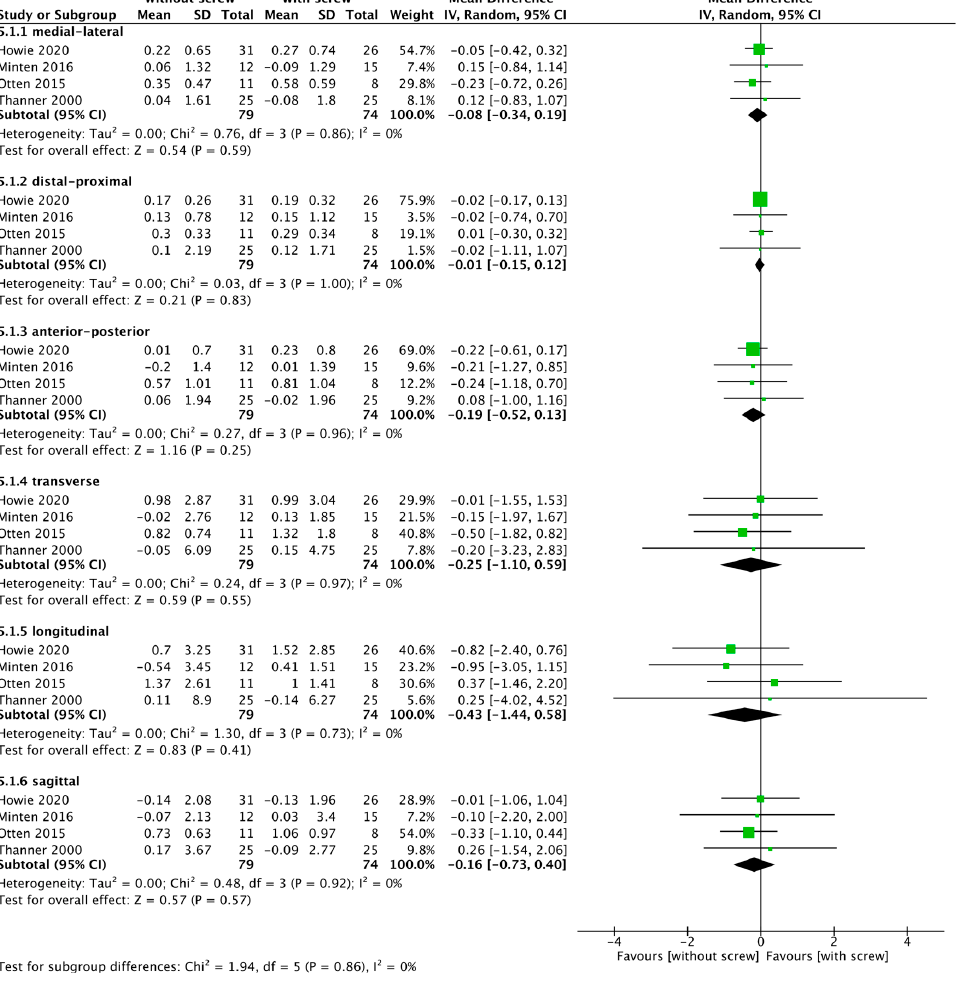
Figure 6. Forest plot of translation and rotation cup movement between the without and with screw fixation groups [10,11,13,14].